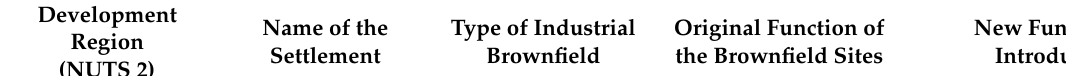
Table 4. Redevelopment projects for industrial